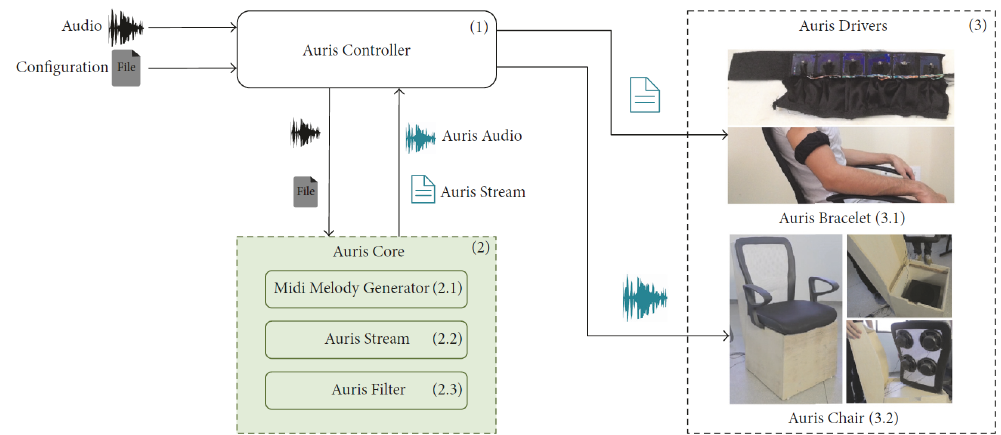
Figure 6. The Auris system for tactile rendering of melodic content, retrieved from in